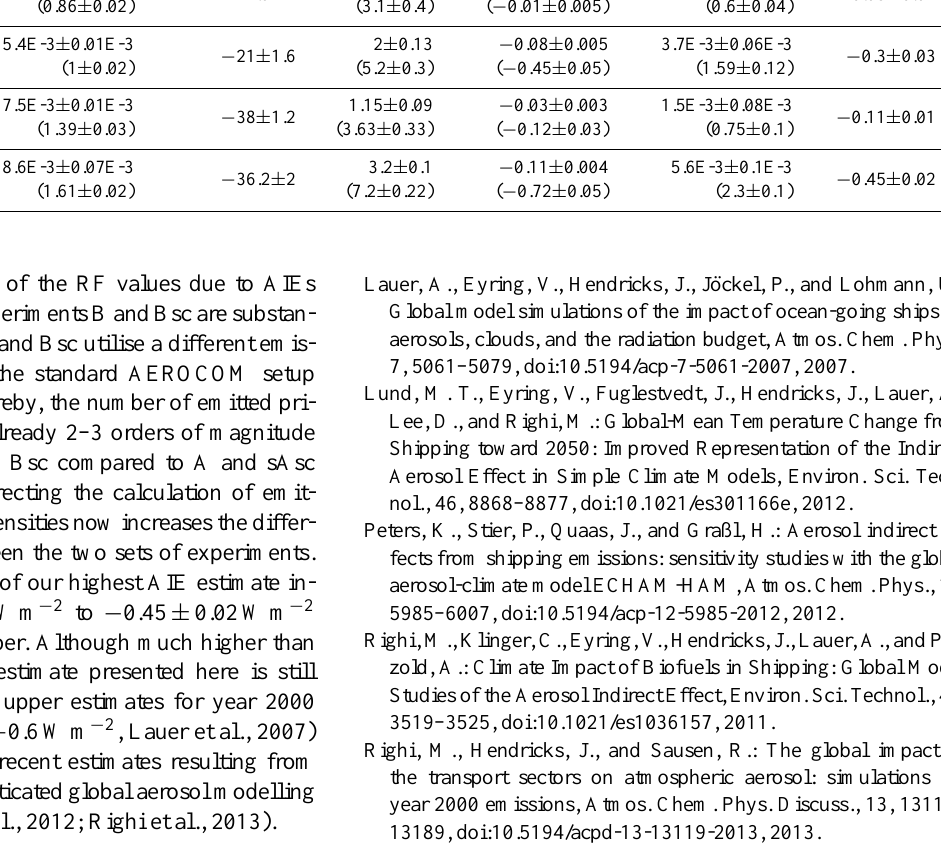
(cid:16) “experiment” − CTRL (cid:17) · 100 . Cf. Table 3 in Peters CTRL